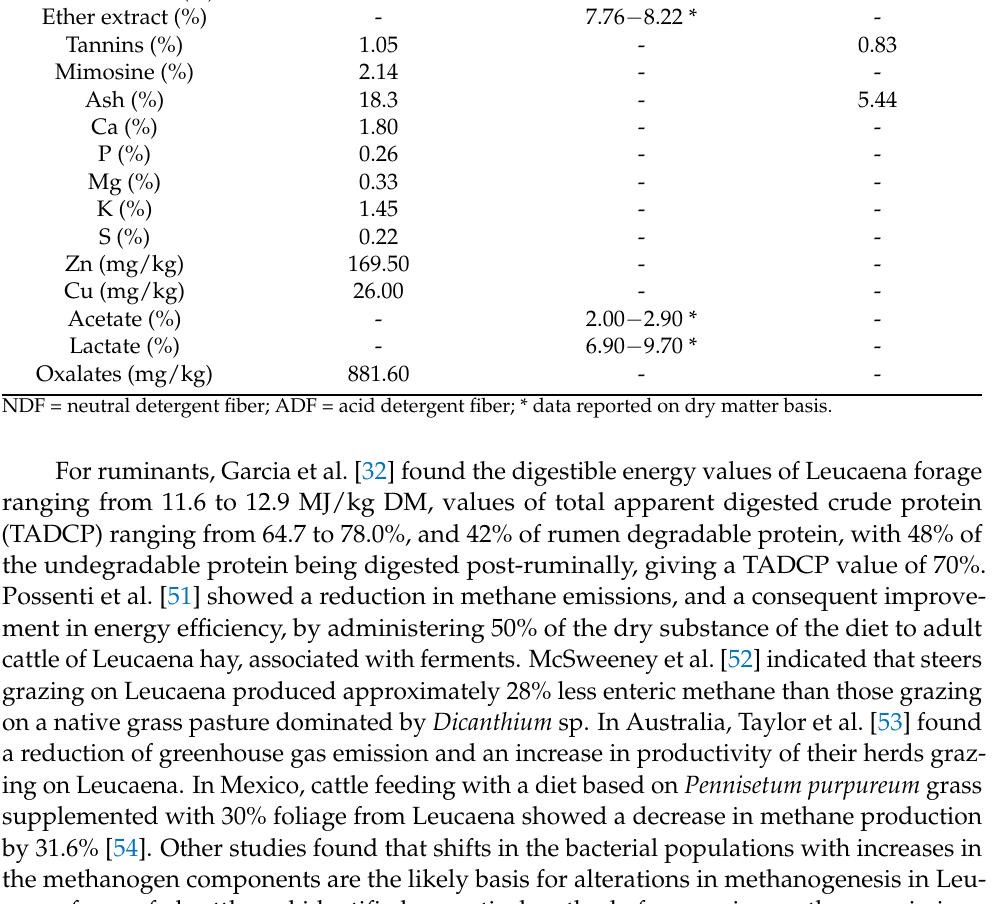
Hemicellulose (%) Ether extract (%)